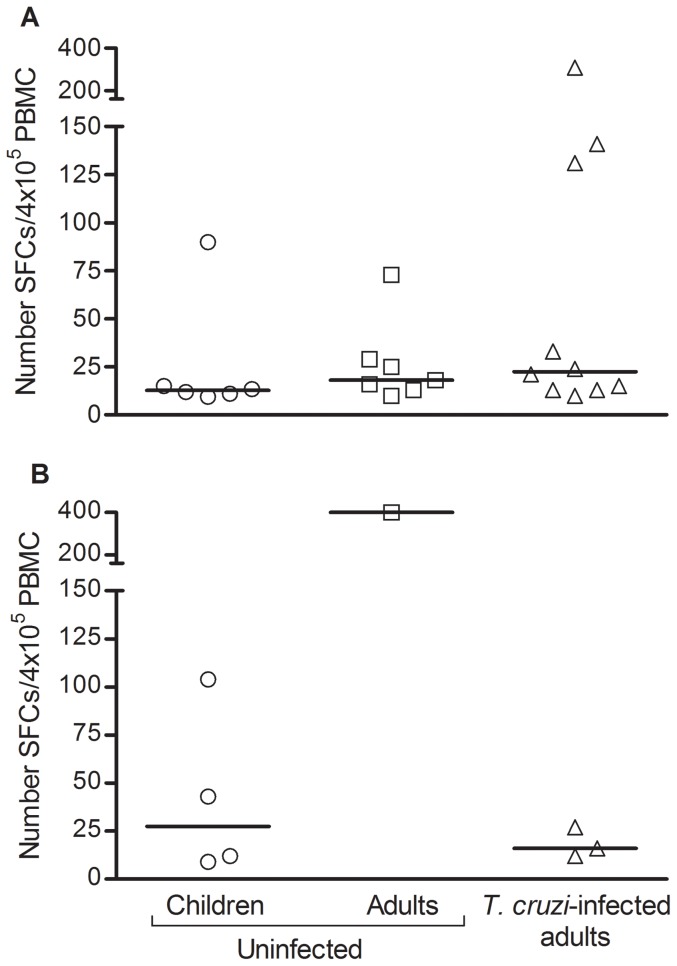
IFN-γ-secreting cells in response to Flu- and tetanus toxoid-derived antigens in uninfected children, uninfected adults and adults with chronic T. cruzi-infection.PBMC from uninfected children (n = 6), uninfected adults (n = 7) and long-term T.cruzi-infected adults (n = 10) were seeded at 4×105 cells/well and stimulated with class-I-restricted Flu-derived peptides (A), tetanus toxoid (B) or media alone for 16–20 h. Each symbol represents the mean spot number of triplicate wells for each patient with positive ELISPOT responses, as defined in material and methods. Spot counts with media alone were subtracted. Vertical lines depicting median values are shown. No significant differences were found among groups.